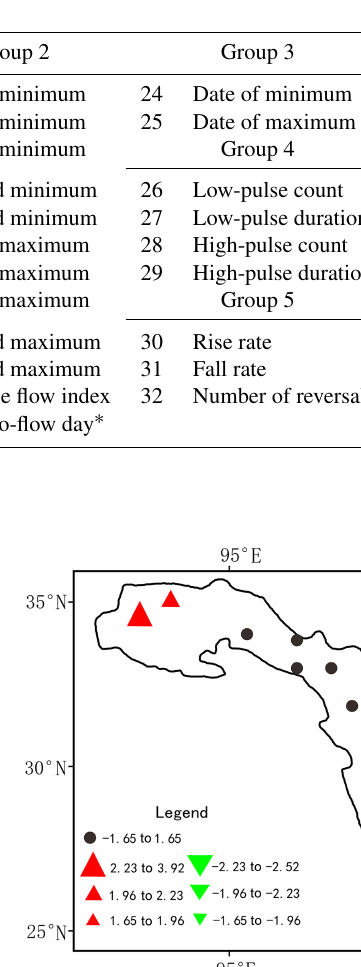
Table 3. The 33 indicators of hydrologic alteration.